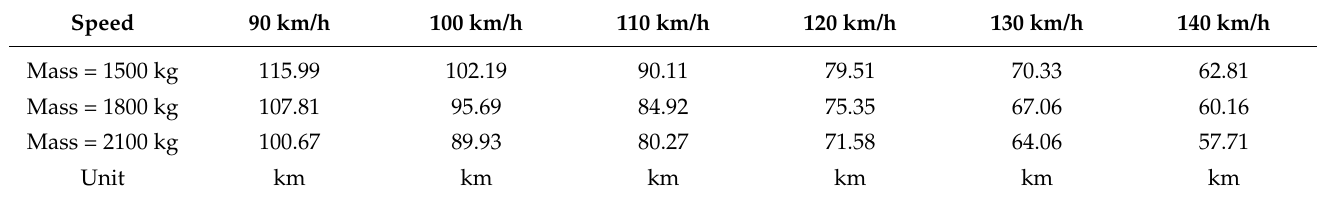
Table 11. Electric drive range for constant speeds and for three variants of vehicle mass.